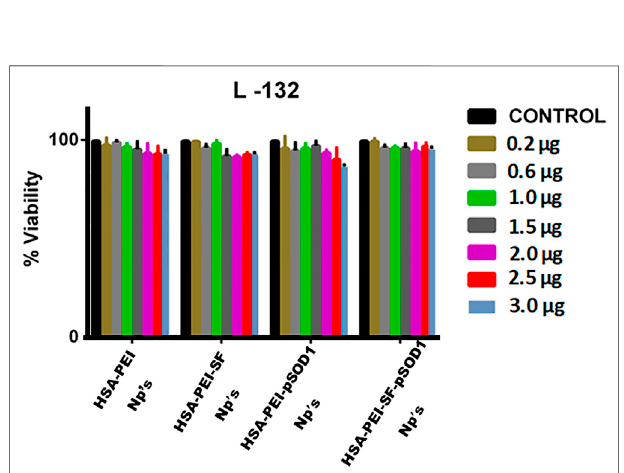
FIGURE 3 | The effects of blank HSA-PEI Np ’ s and loaded with SulforaphaneandpSOD-1transgeneoncellproliferationandviabilityofL-132 cells as determined by the MTT assay. Concentration-dependent cytotoxic effectsofnanoparticleswereevaluatedafter96 hincubation.Resultsare represented as mean ± SD. *Signi fi cant difference from control ( p < 0.05).